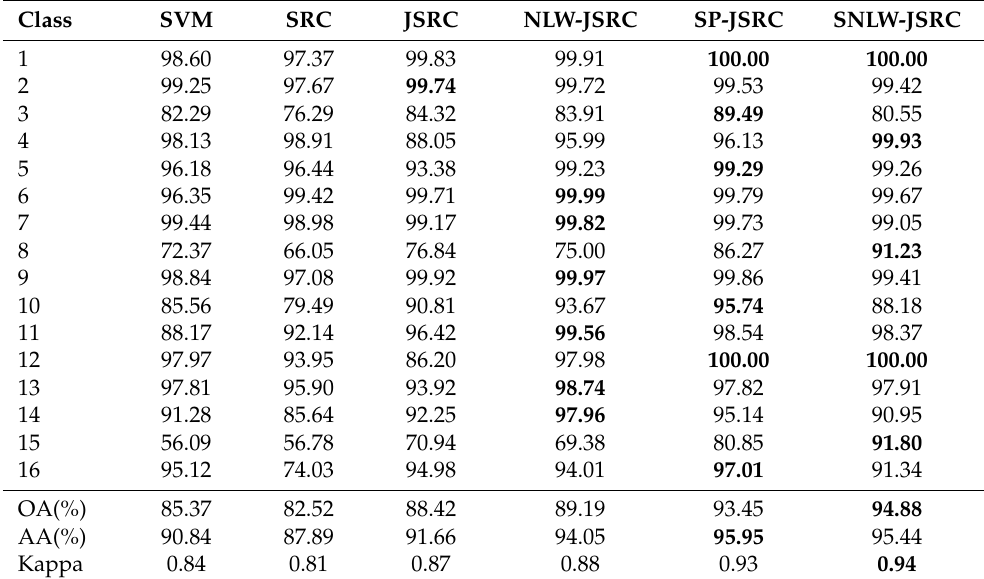
Table 6. Accuracy of Salinas classification results (the best result in each row is highlighted in